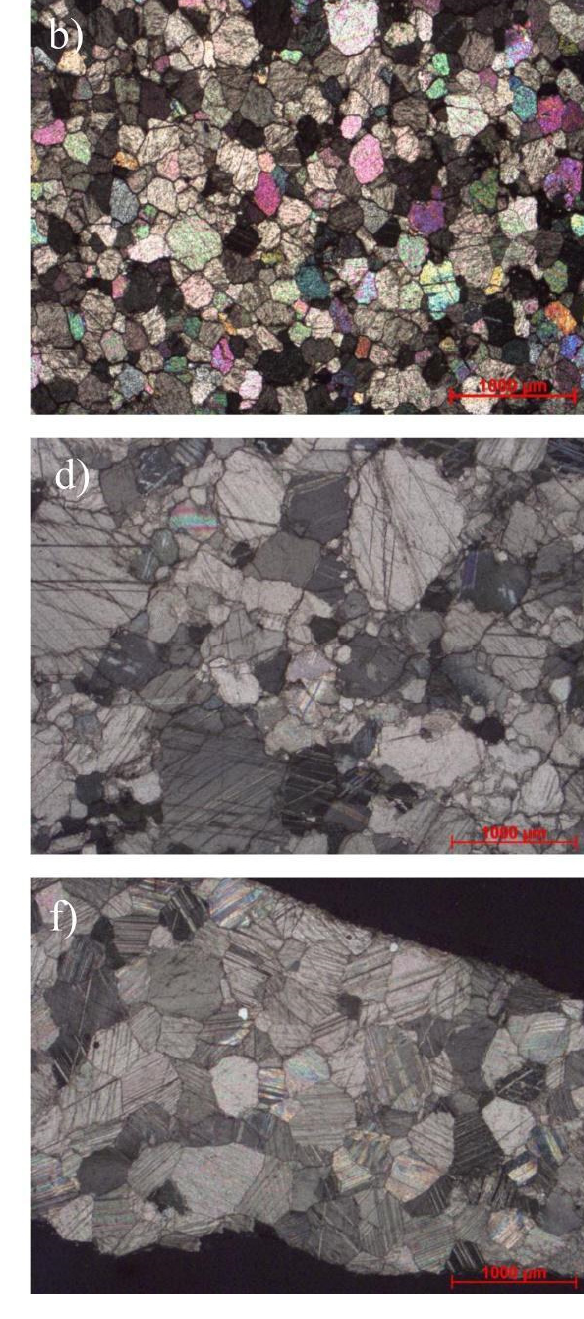
Table 3. Mineralogical composition (semiquantitative data) of mortars.